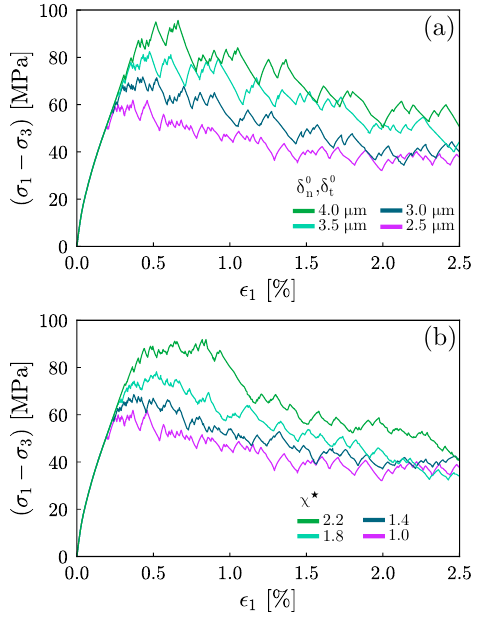
Figure 4. Comparison of the mechanical response of an REV for di ff erent failure surface parameters δ 0 damage parameter χ (cid:63) at δ 0